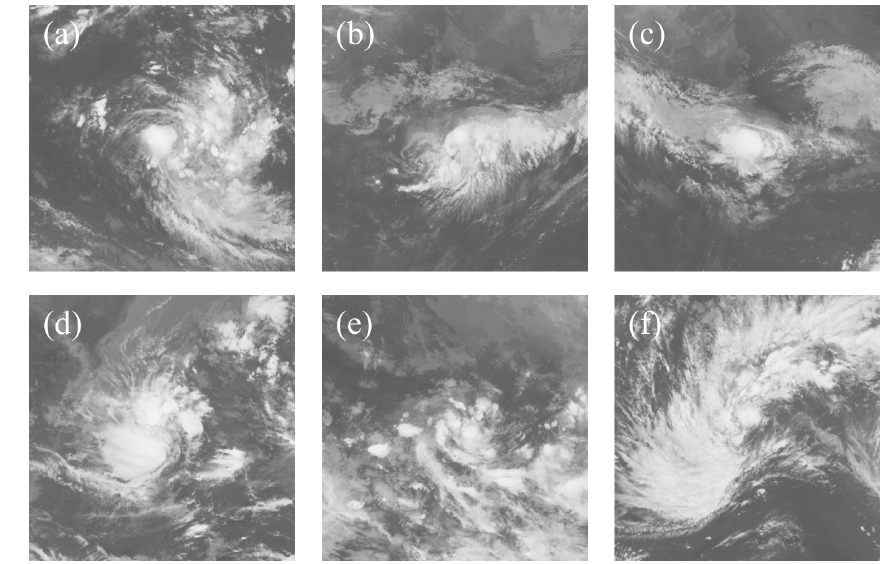
Figure 9. L images of non-TCs misjudged as TC images during testing process.